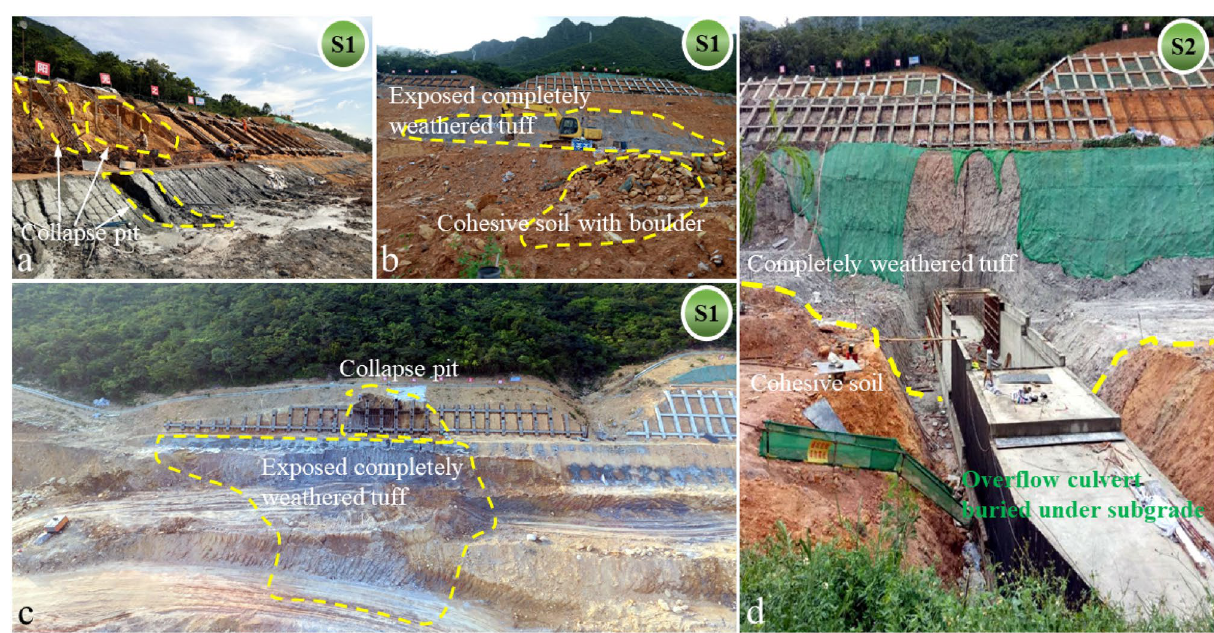
Figure 10. Excavation during construction of the roadside slope and toll gate (S1 and S2 correspond to the time nodes in Fig. 9). ( a ) Collapse pit caused by roadside slope excavation. ( b ) Distribution of weathered tuff on roadside slope and cohesive soil containing boulder. ( c ) Completely weathered tuff exposed during excavation. ( d ) Construction of the overflow culvert buried under